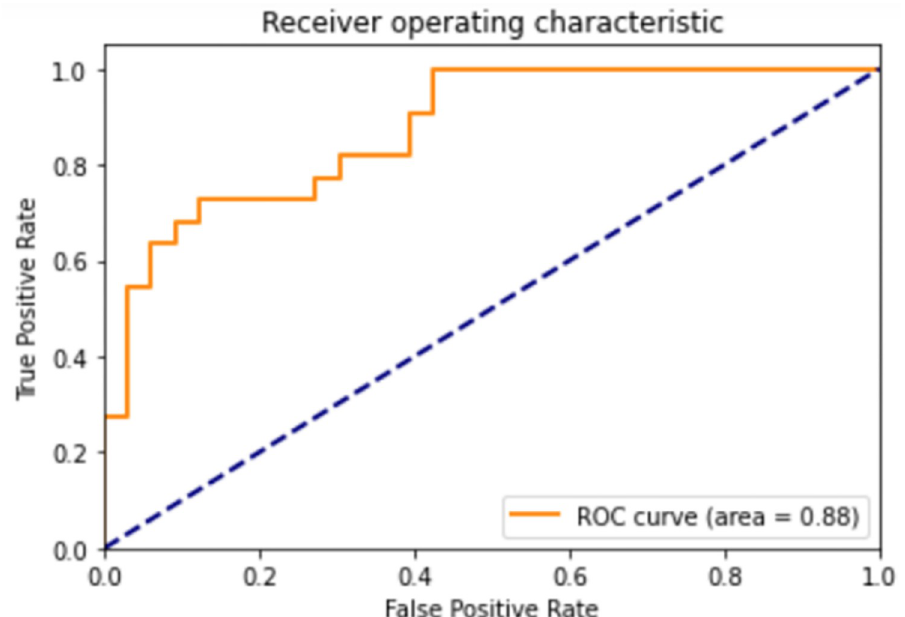
Fig 4. Receiver operating characteristic (ROC) curve of the proposed model with D9:1.